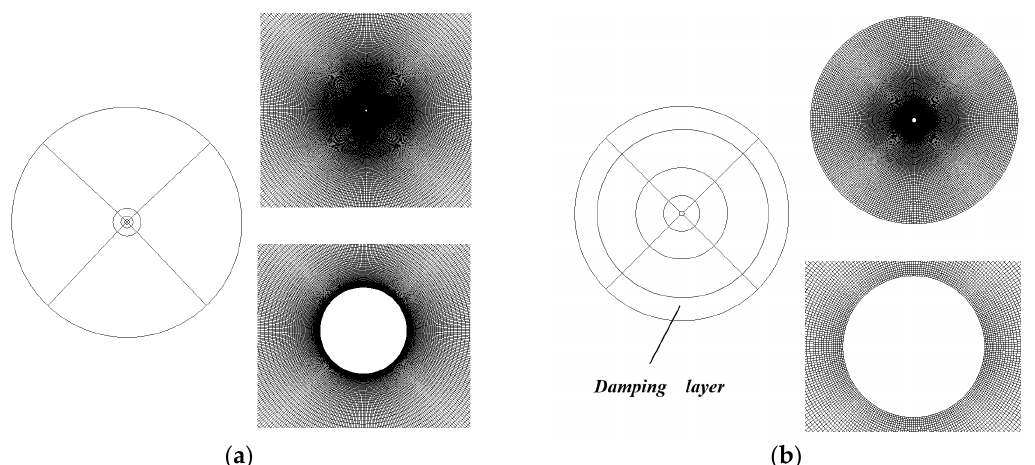
Figure 8. The CFD and CAA computation grids. ( a ) CFD grid. ( b ) CAA mesh.